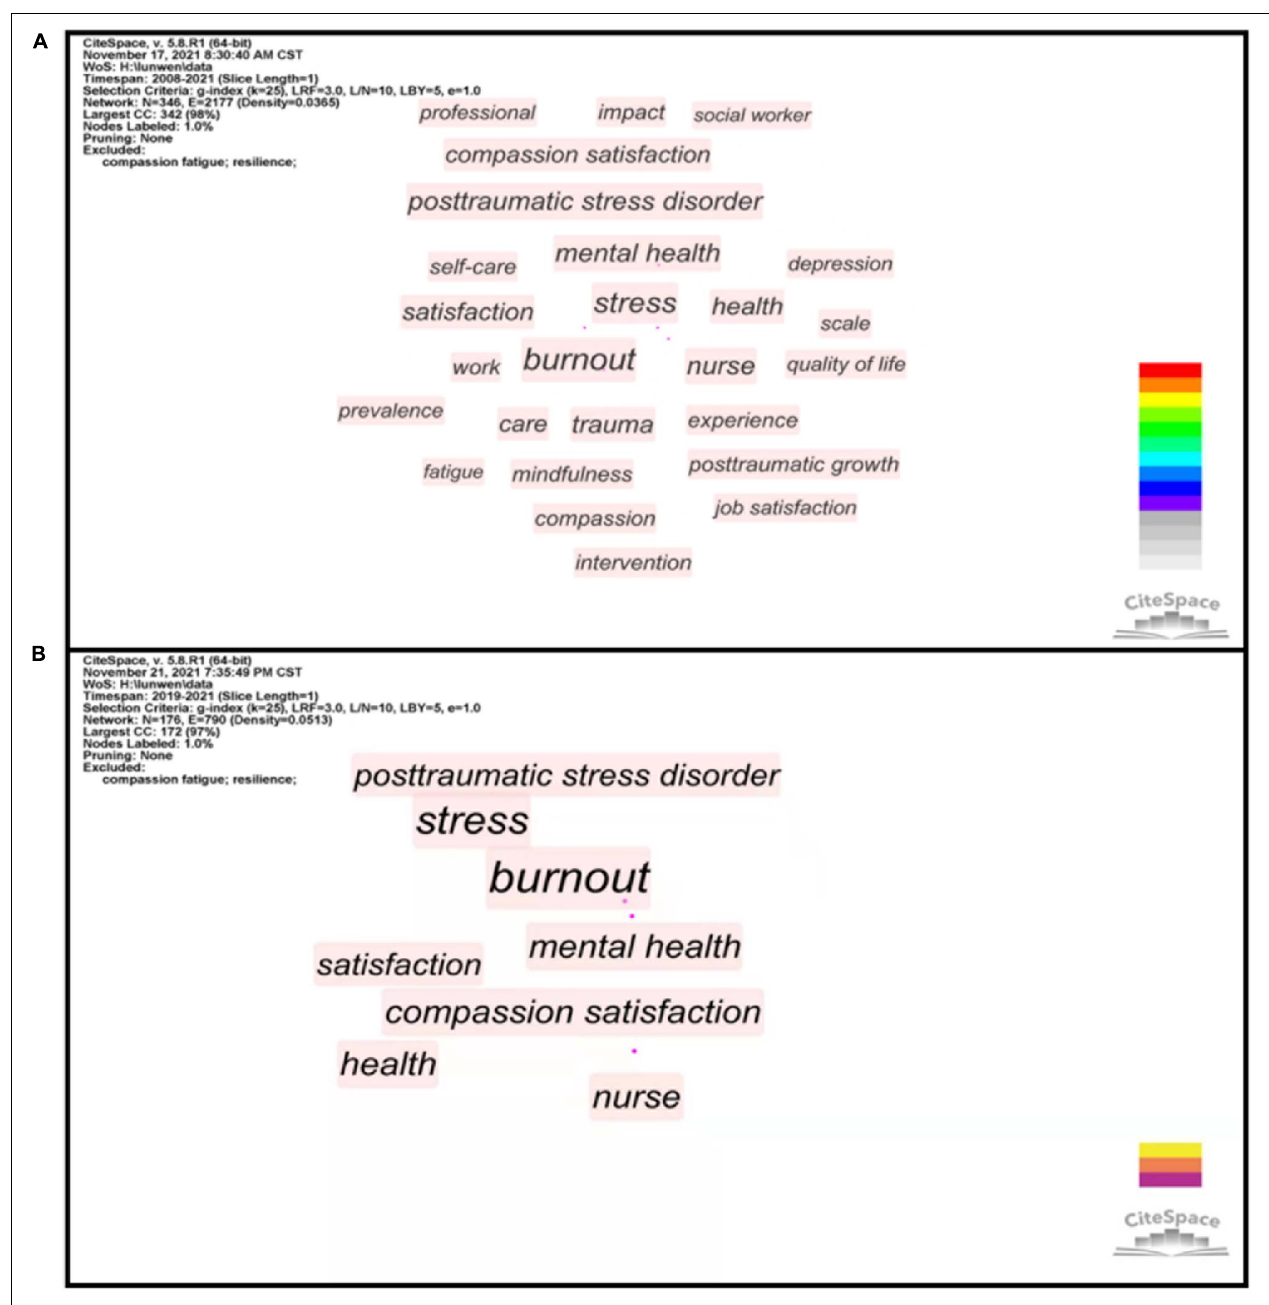
FIGURE 8 | The co-occurrence network of keywords during 2008–2021 (A) and the COVID-19 pandemic (B) .